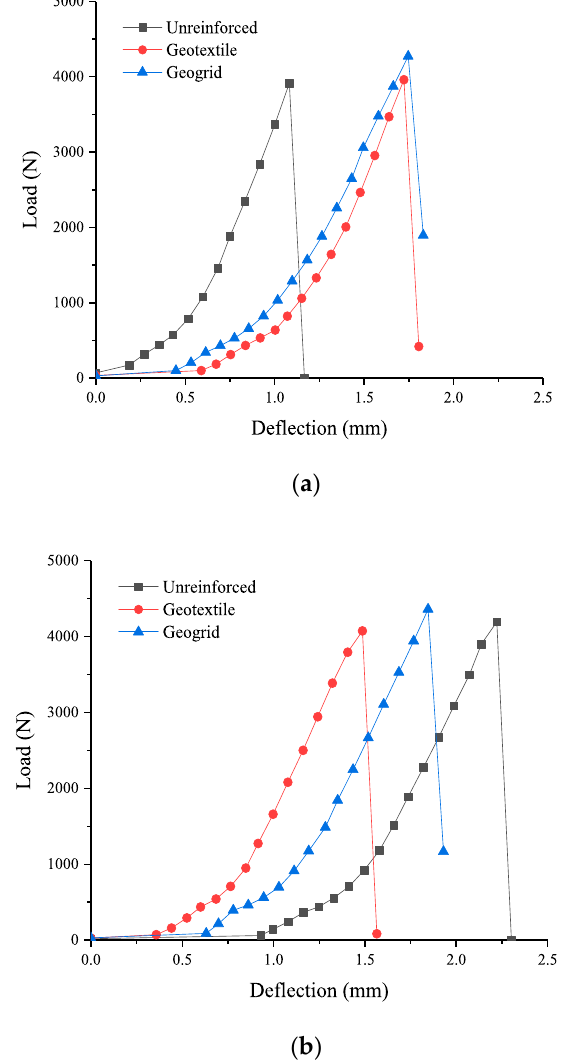
Figure 3. The load vs. deflection curves. ( a ) AC-13C and ( b ) AC-20C. Table 5. The average values of the corresponding characteristic